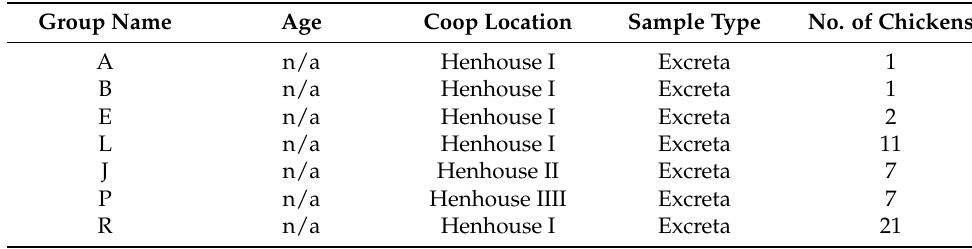
Table 5. Groups of free-range